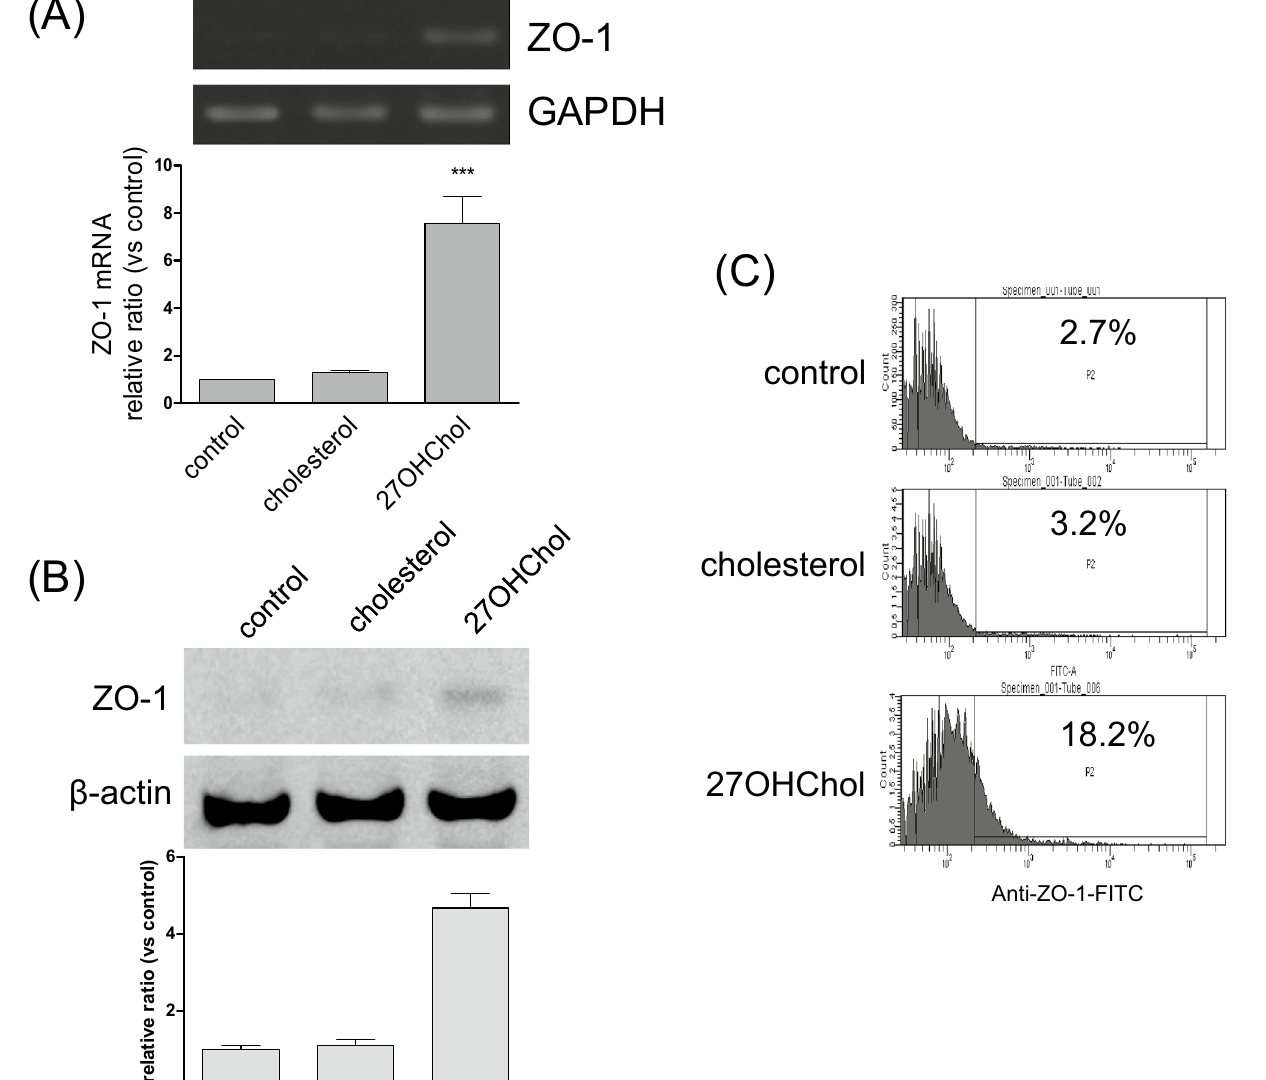
Figure 1. The ZO-1 expression following treatment with 27OHChol. THP-1 cells (1 × 10 6 cells/60-mm culture dish) were treated for 48 h with 5 µg/ml of cholesterol or 2.5 µg/ml of 27OHChol. ( A ) The transcript levels of ZO-1 were assessed using RT-PCR and real-time PCR. The data are expressed as the mean ± SD (n = 3 replicates/ group). *** P < 0.01 versus control. ( B ) ZO-1 was analyzed using Immunoblot. ( C ) After immunostaining ZO-1, the cells were analyzed by flow cytometry. The results are representative of three independent